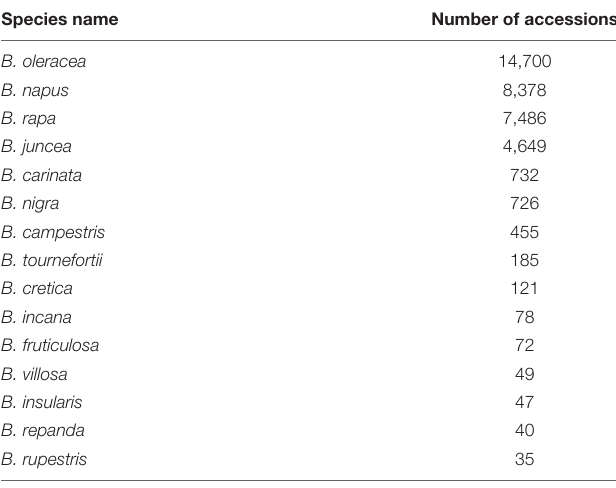
TABLE 1 | Coverage of Brassica germplasm in